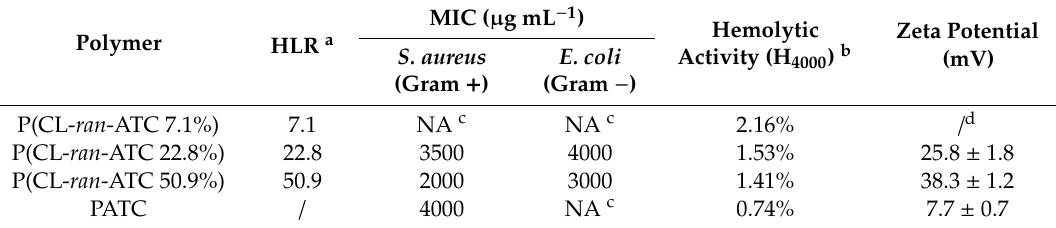
MIC ( µ g mL − 1 ) Hemolytic Zeta Potential E. coli Activity (H 4000 ) b (mV) S. aureus (Gram + ) (Gram − )